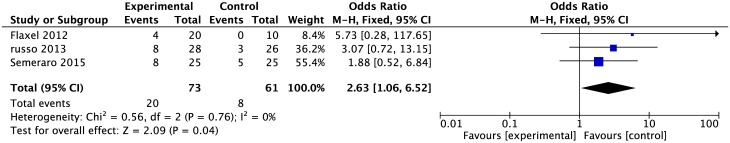
Forest plot showing the odds ratio of foreign body sensation after combined treatment or anti-VEGF alone using a fixed-effects model.